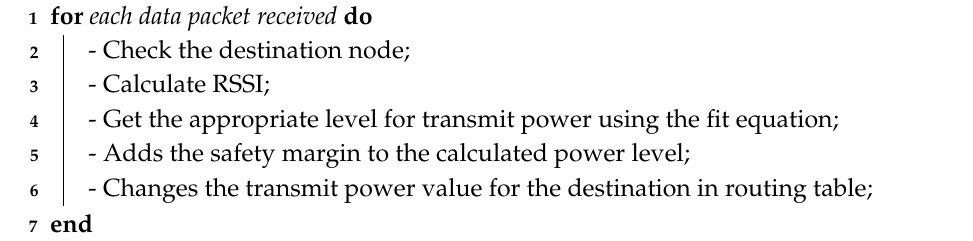
Algorithm 1: Identification of the P TX level of a destination